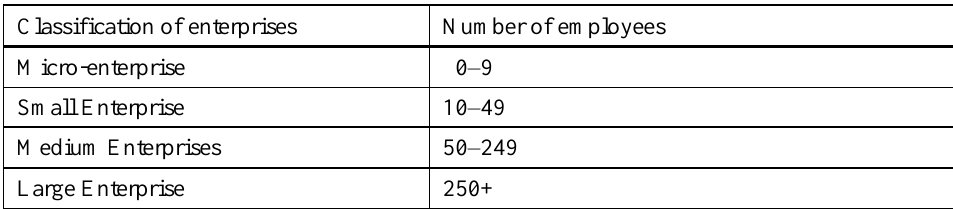
Table 6. Classification of enterprises by size in Serbia